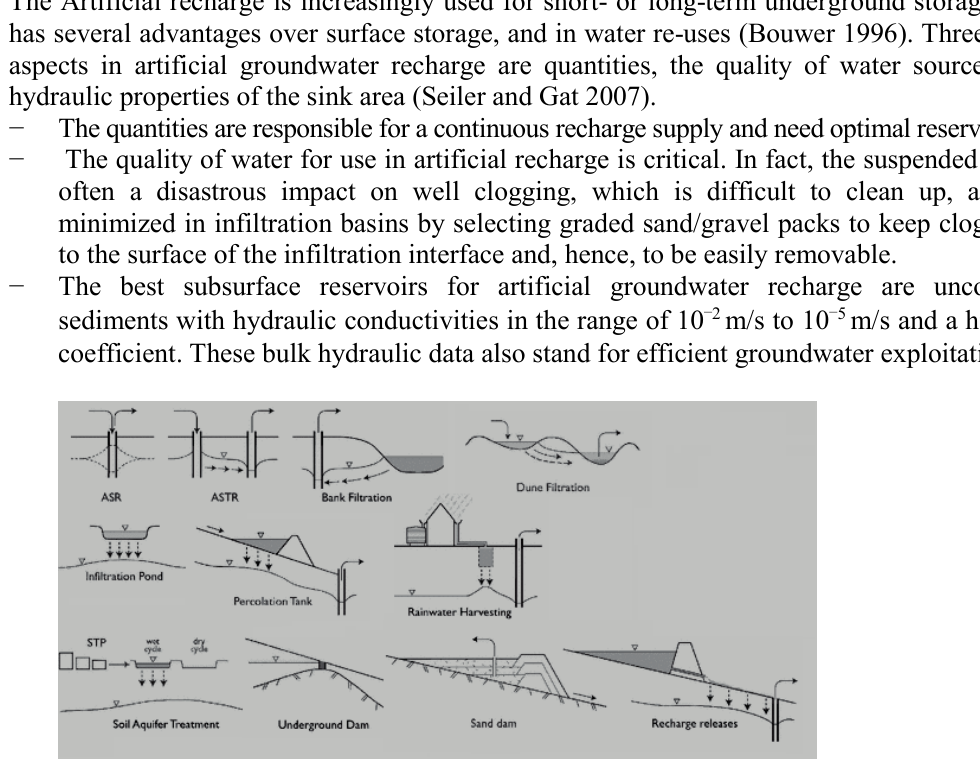
Fig. 1 Schematic of types of aquifer of management recharge; after Dillon